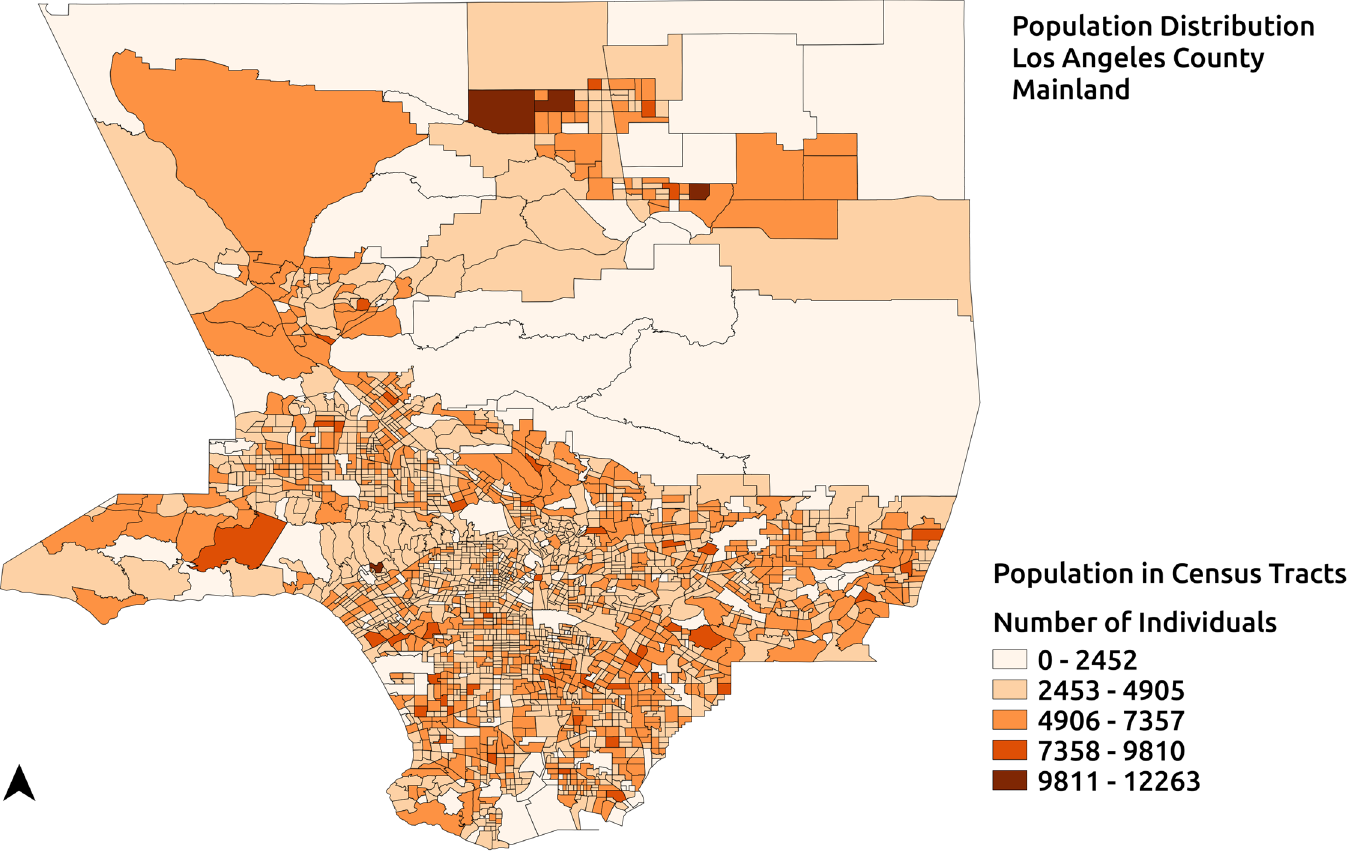
Fig 4. Population Distribution. Population distribution of the region representing the mainland of Los Angeles